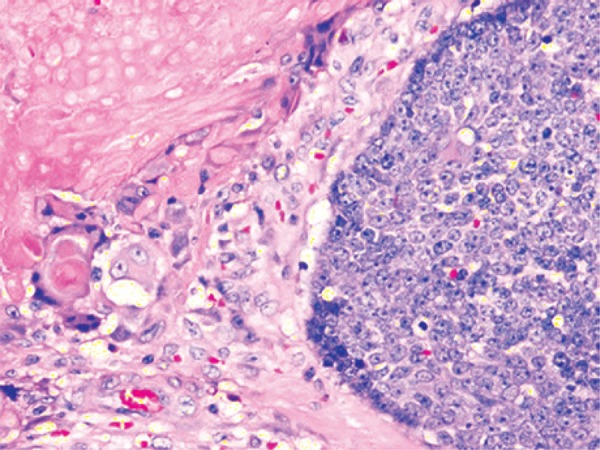
Histopatologia mostrando as duas populações celulares predominantes do pilomatricoma - células basofílicas basaloides com escassez de citoplasma, núcleos proeminentes e margens indistintas, e as “células fantasmas” eosinofílicas e anucleadas, com margens relativamente distintas, com zona transicional no entremeio. Com o envelhecimento do tumor, as células basaloides sofrem apoptose e transformam-se em “células fantasmas”. Hematoxilina-eosina x 400